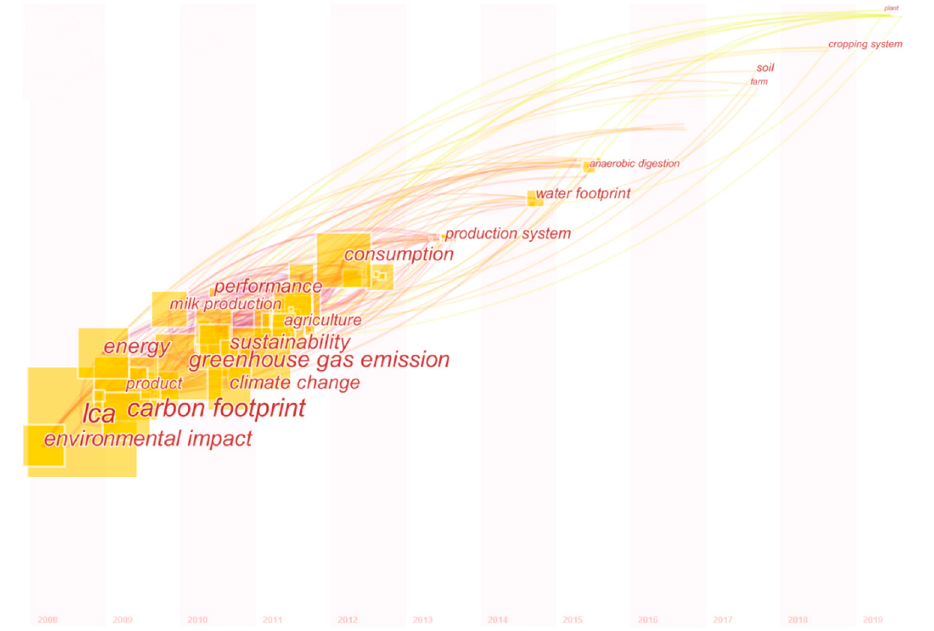
Figure 8. Time-zones of keywords.